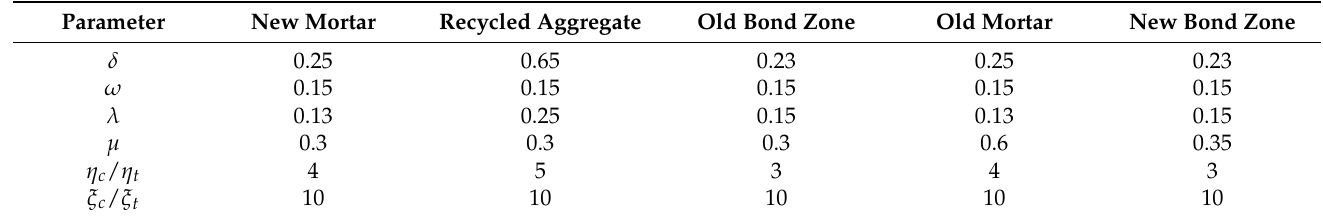
Table 1. Material parameter